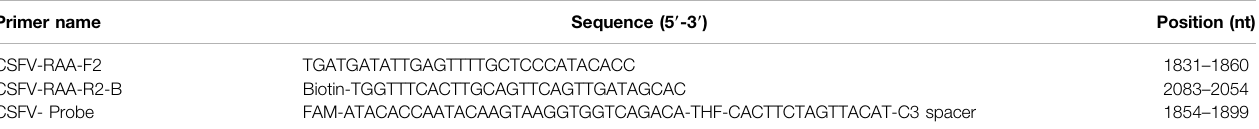
CSFV RAA-strip, with a positive rate of 33.3% and a negative rate of 66.7%; 8 positive samples and 34 negative samples were detected by conventional PCR, giving a positive rate of 19%